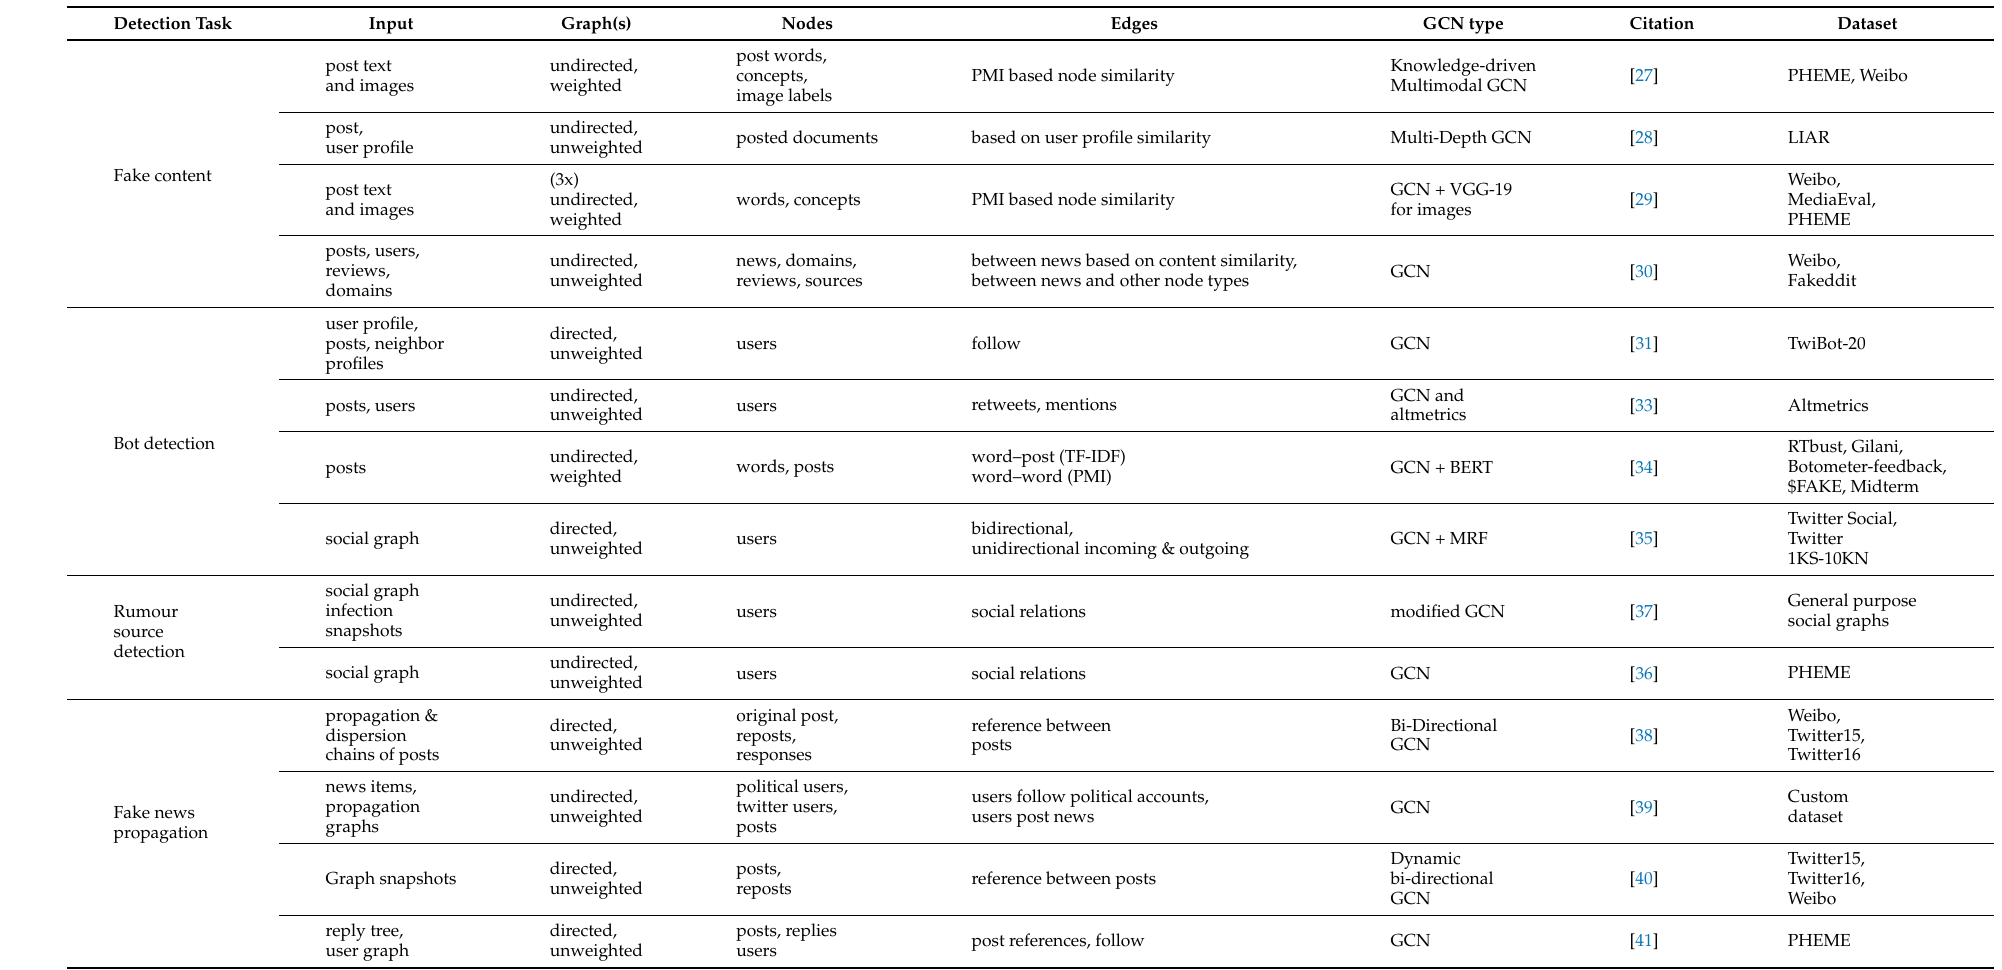
Table 1. The summary of methods that use GCN for detecting fake news, fake accounts, fake news sources or fake news propagation